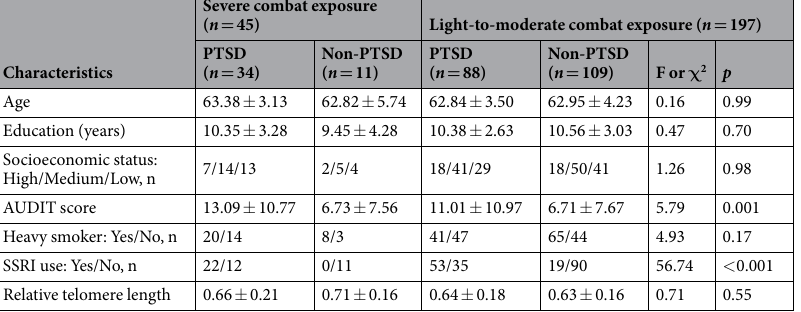
Table 1. Socio-demographic and clinical characteristics of PTSD and non-PTSD subjects stratified by trauma exposure levels. AUDIT, Alcohol Use Disorders Identification Test; SSRI, selective serotonin reuptake